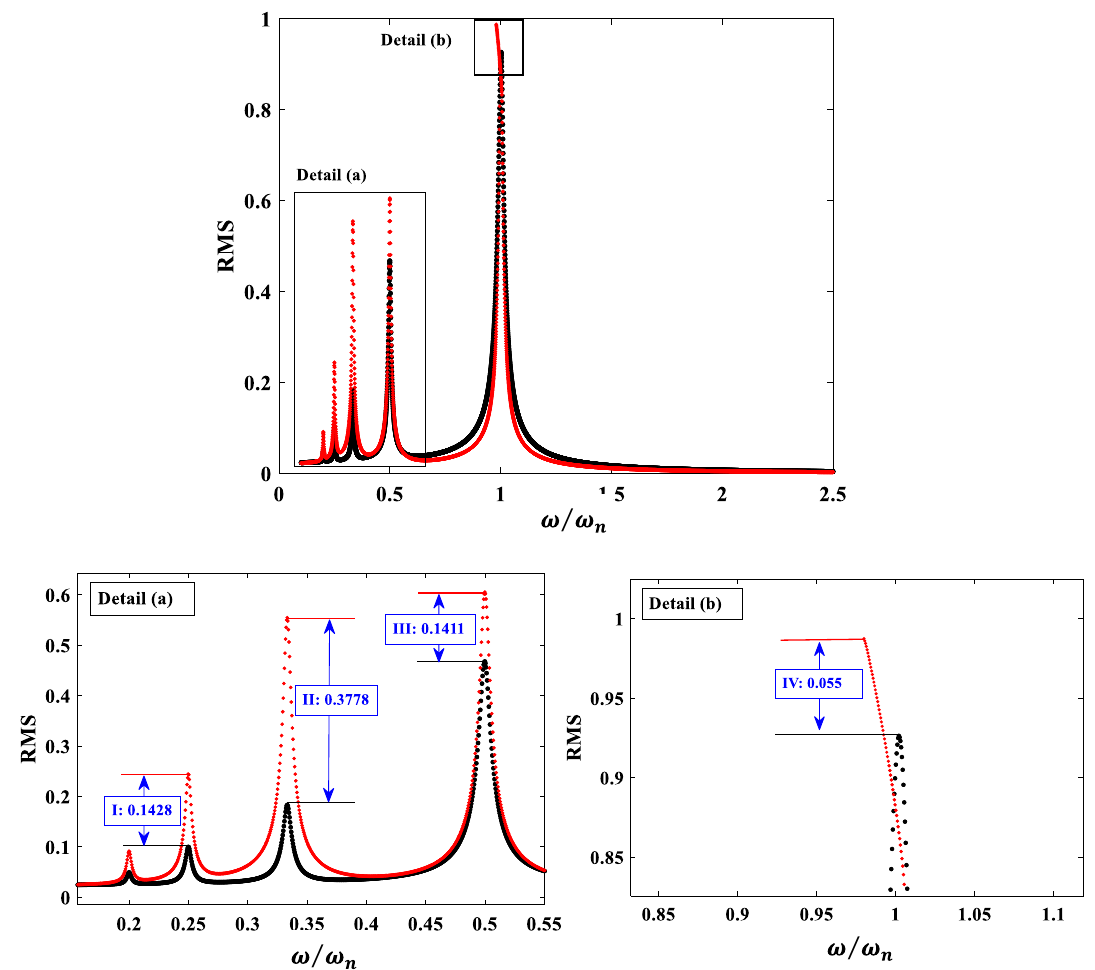
Fig. 4 RMS diagram of forward and backward motions, black dot—case-1, red